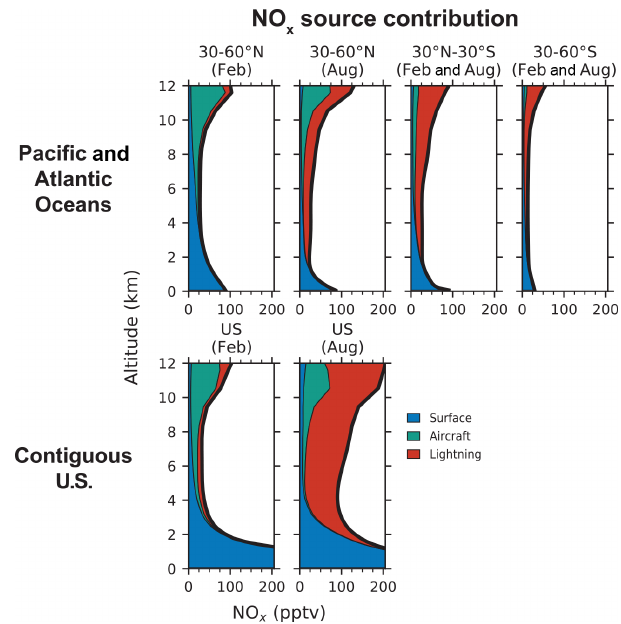
Figure 8. Vertical profiles of NO x concentrations from three pri- mary source categories over the Pacific and Atlantic oceans and over the contiguous U.S. in GEOS-Chem. The source categories include surface emissions (fuel combustion, soil, fertilizer use, and fires), aircraft emissions, and lightning emissions. The profiles for the Pacific and Atlantic oceans are means for the regions sampled in ATom (160 ◦ E–160 ◦ W and 25–50 ◦ W in the Northern Hemisphere and 160 ◦ E–160 ◦ W and 0–30 ◦ W in the Southern Hemisphere) and are separated into three latitude bands. The northern midlatitude (30–60 ◦ N) profiles are further separated by month (February and August), while the other profiles are averages for the 2 months. The profiles for the contiguous U.S. (defined as 25–50 ◦ N and 65– 130 ◦ W) are shown separately for February and